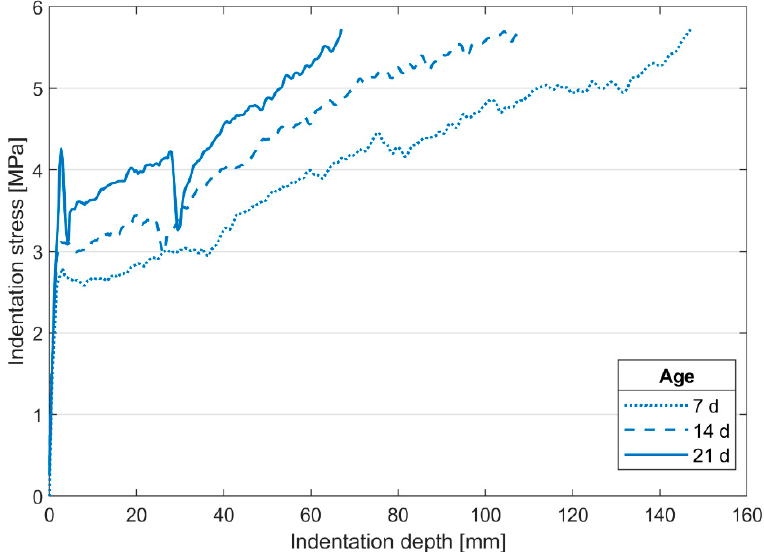
Figure 2. General loading response from the penetration test at 7, 14, and 21 days for the control sample.